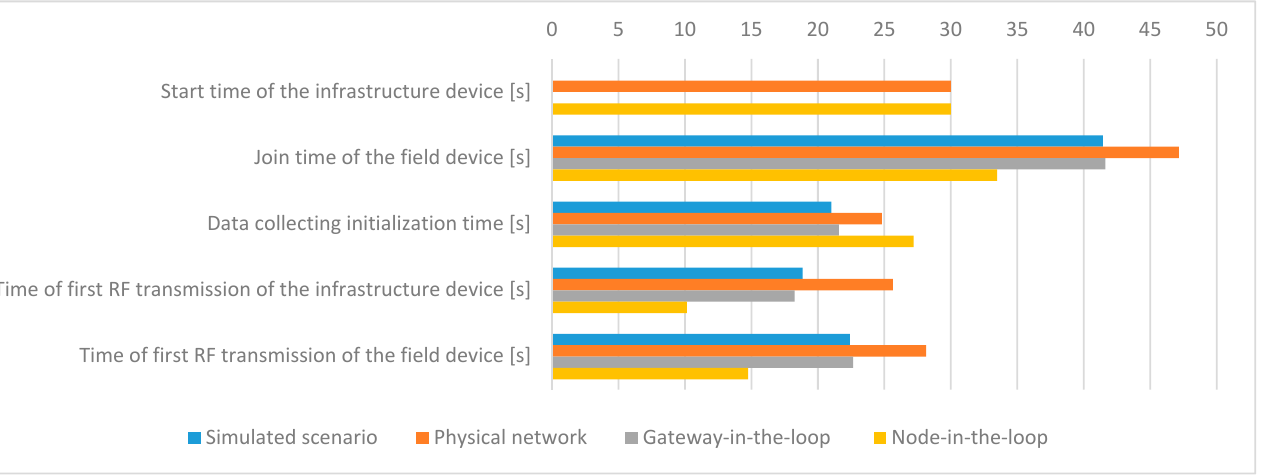
Figure 11. Mean values of the timing information metrics.